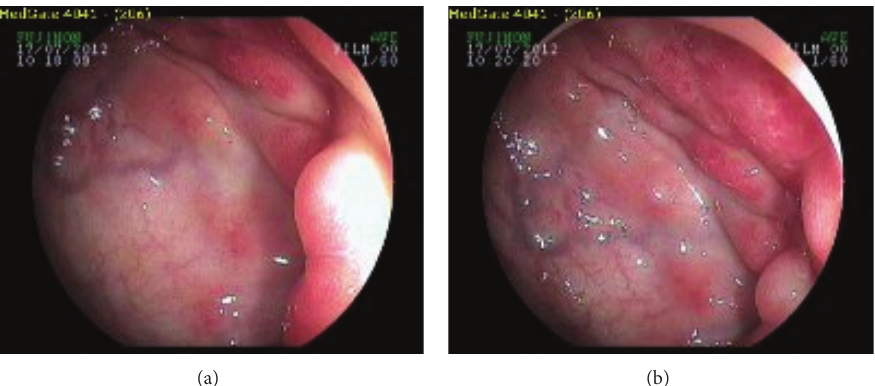
Figure 1: (a), (b) Colonoscopic view of the signet cell tumour in sigmoid colon. The colonoscopy could not been completed according to the obstruction.